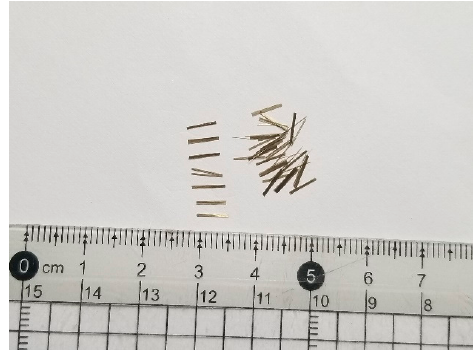
Figure 1. Basalt fiber.